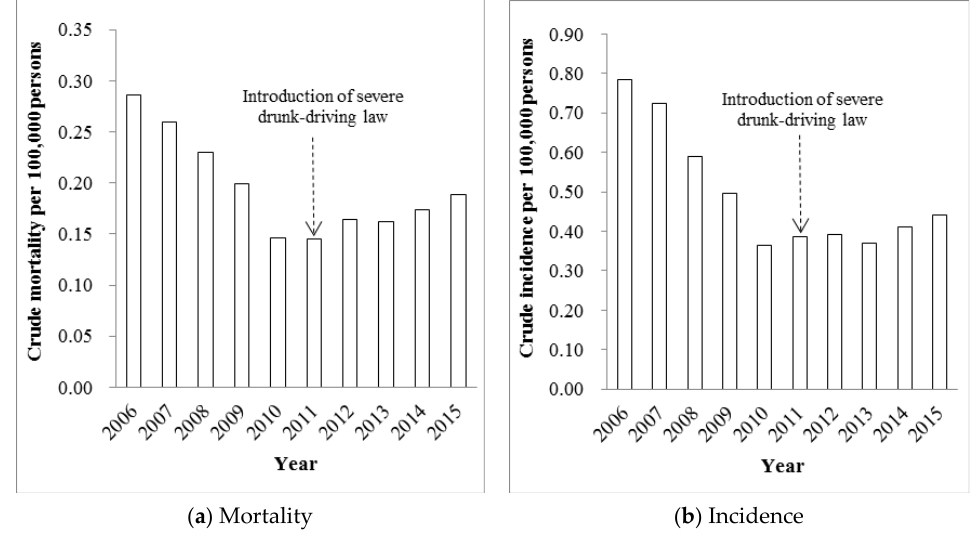
Figure 2. Crude mortality and incidence per 100,000 persons from road traffic crashes attributed to alcohol use in China based on police data, 2006–2015. Published police data only covered crude numbers of deaths and injuries from 2006 to 2015 from road traffic crashes attributed to alcohol use. China implemented the more severe drunk driving law in